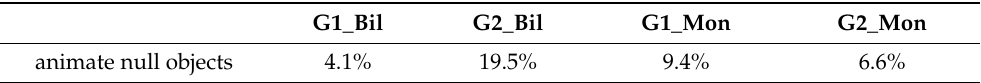
Table 4. Rate of animate null objects in the spontaneous speech of four speaker groups (adapted from (Rinke et al. 2018)). G1_Bil G2_Bil G1_Mon G2_Mon animate null objects 4.1% 19.5%